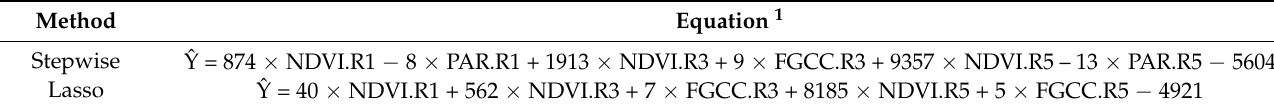
Table 5. Stepwise and Lasso regression equations to best predict soybean yield.